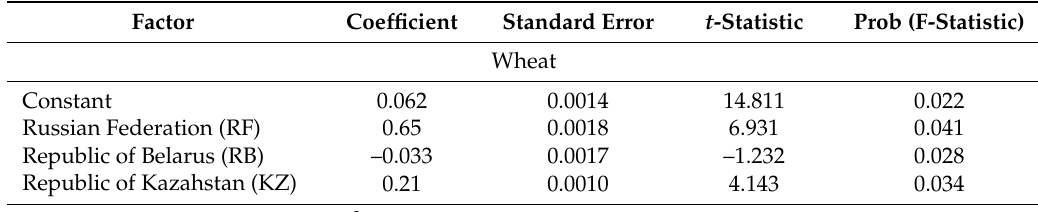
Table 2. The results of the comparison of EAEU countries in terms of wheat competitiveness based on regression analysis from 2010 to